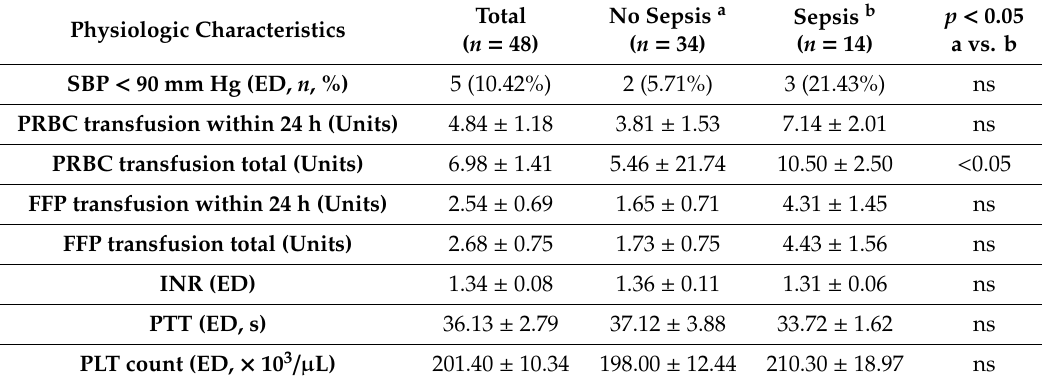
Table 2. Physiologic characteristics of the study population. Data are given as mean ± standard error of the mean; p < 0.05. Abbreviations: a, no sepsis group; b, sepsis group; ED, emergency department; FFP, fresh frozen plasma; INR, international normalized ratio; ns, no significance; PLT, platelet; PRBC, packed red blood cells; PTT, activated partial thromboplastin time; and SBP, systolic blood pressure. Physiologic Characteristics